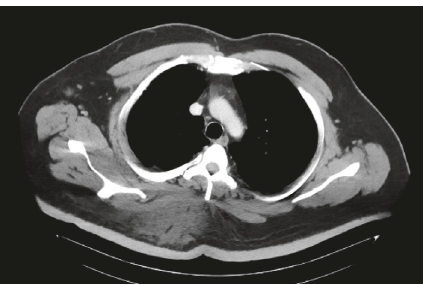
Figure 2: CT scan of the chest showing a large area of subcutaneous tissue density of right upper back.